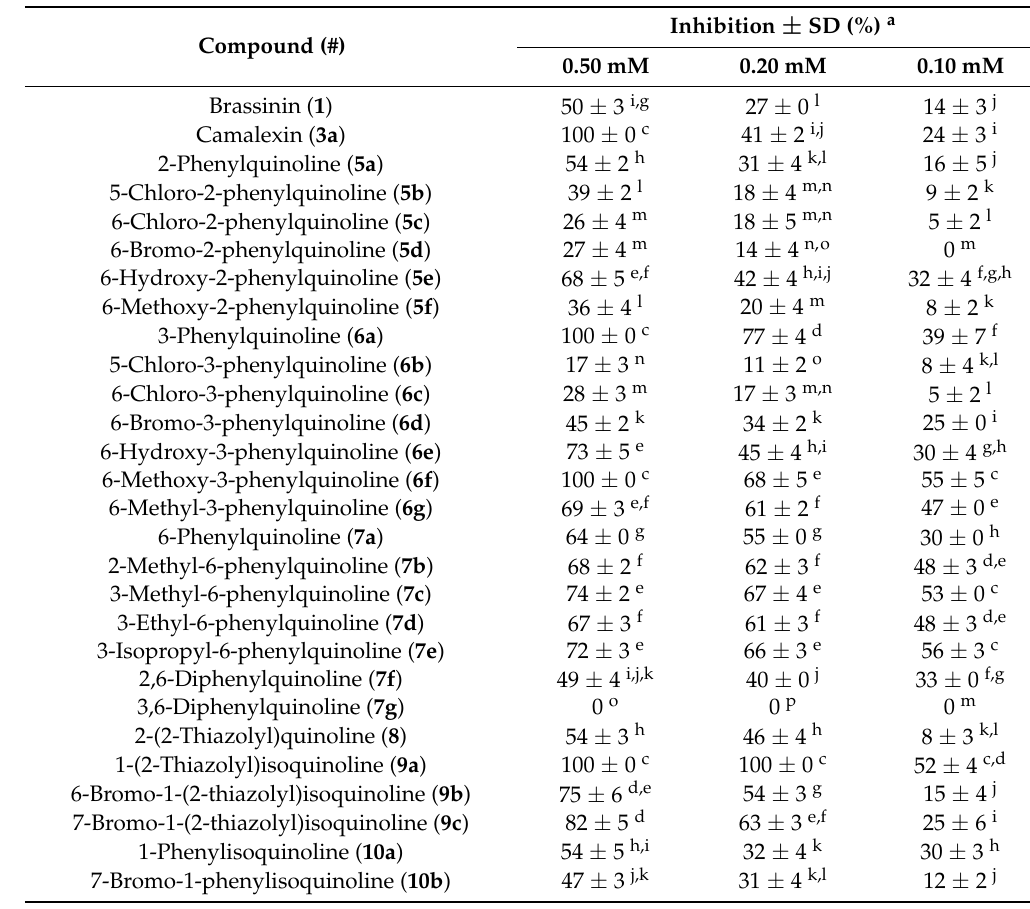
Table 2. Antifungal activity a of the phytoalexins brassinin ( 1 ), camalexin ( 3a ), quinolines 5a – 8 , and isoquinolines 9a – 10b against Leptosphaeria maculans